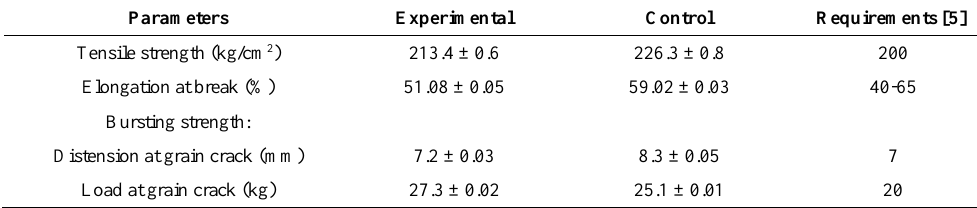
Table 4. Physical properties of processed experimental and control leather